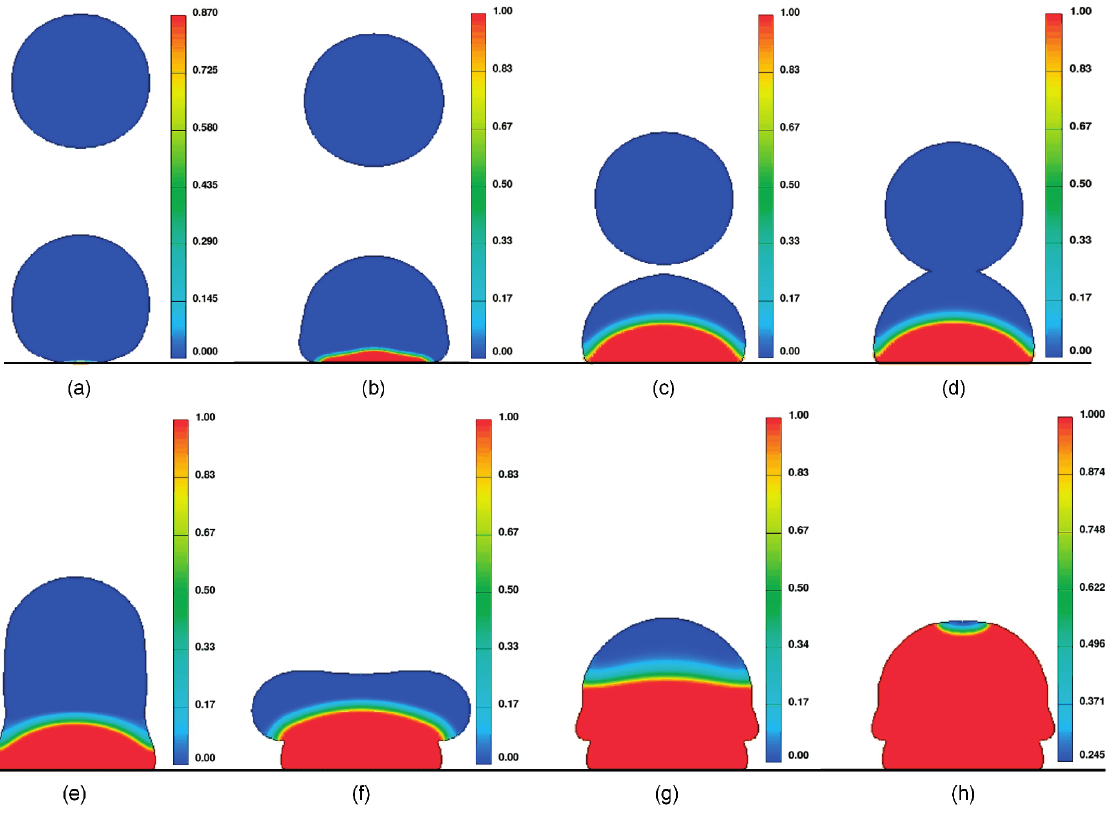
Figure 5. Simulated deformation and solidification of a 100- μ m diameter aluminum alloy droplet, initially at 960 K, and its impingement on a stainless substrate at a velocity of 1.5 m/s; the distance between the two successive droplets is 160 μ m and time is measured from the moment of impact: ( a ) t = 0 μ s; ( b ) t = 9.2 μ s; ( c ) t = 55.2 μ s; ( d ) t = 59.8 μ s; ( e ) t = 73.6 μ